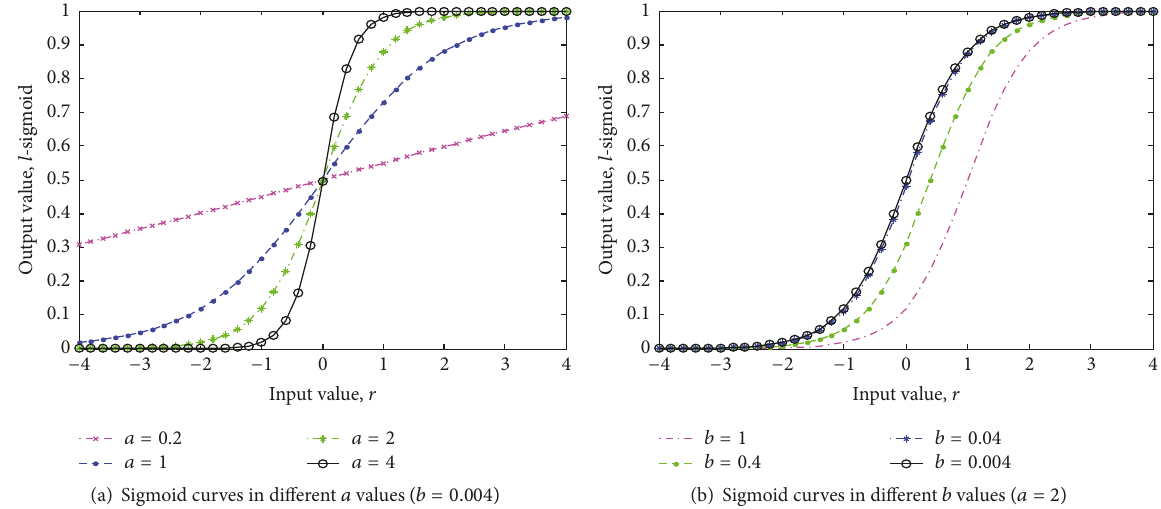
Figure 5: Sigmoid function curves.